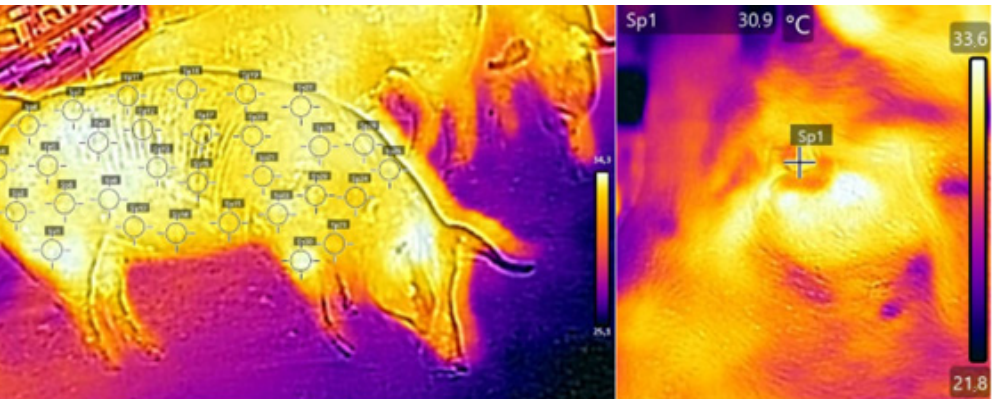
Figure 1. Thermographic image of the body of a sow with 30 points highlighted to calculate mean body surface temperature ( left ). Thermographic image of the eye of a sow with one highlighted point ( right ) during